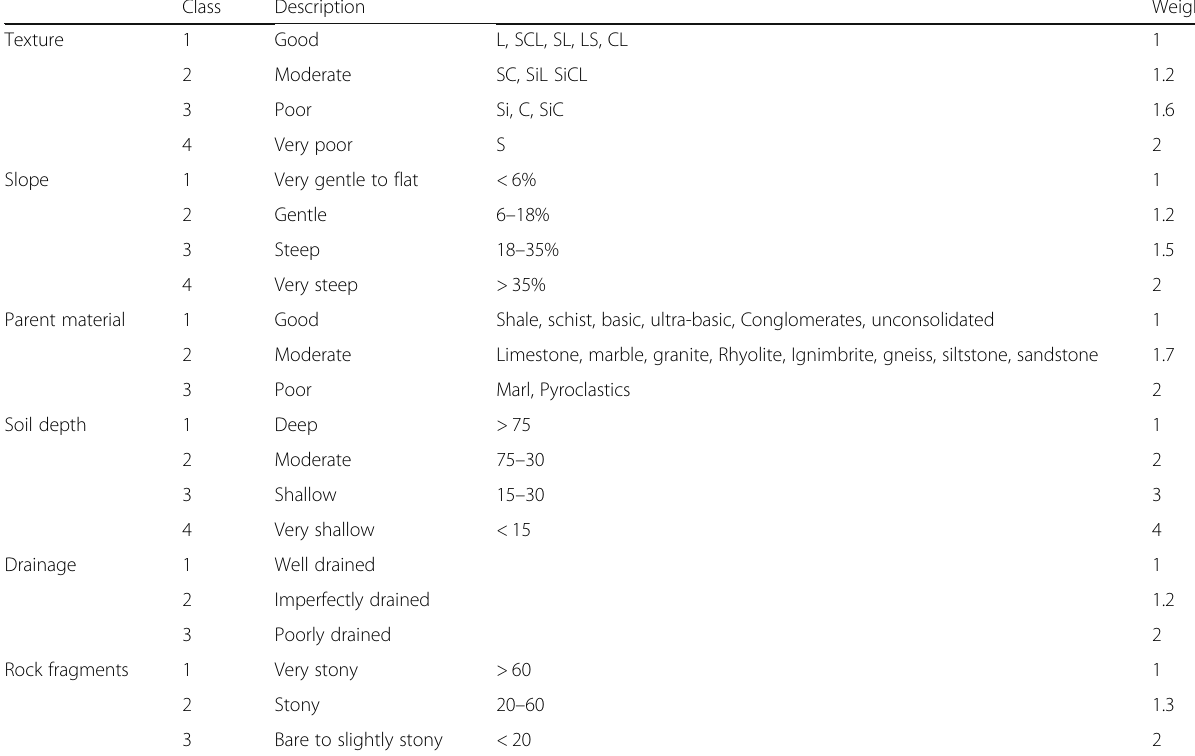
Table 5 Assigned weighing indices for various parameters used for assessment of soil quality (Kosmas et al. 1999) Class Description